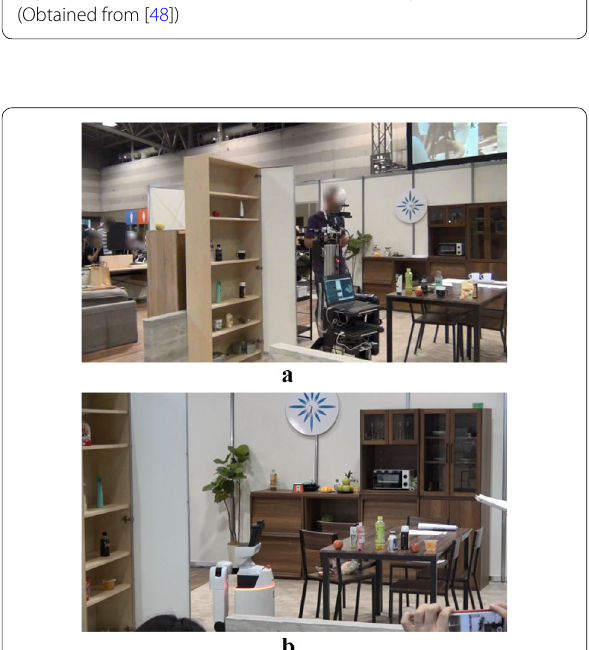
Fig. 27 Storing Groceries by Hibikino-Musashi@Home in